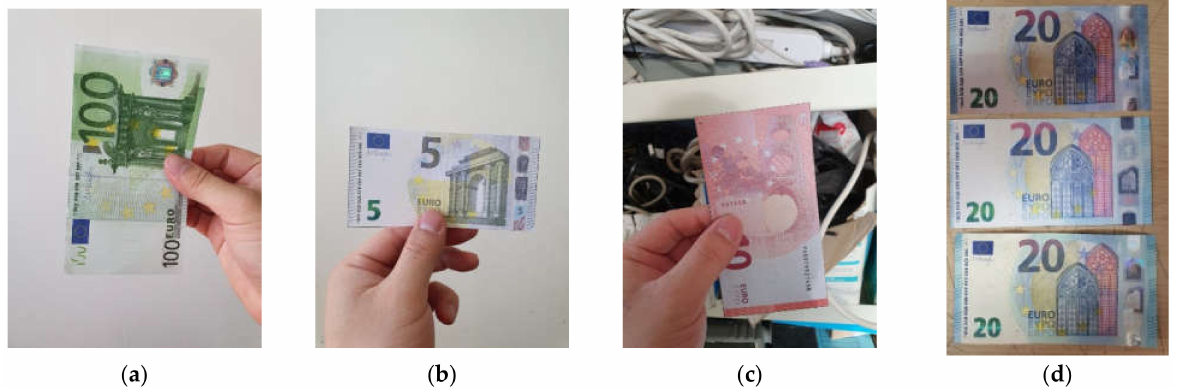
Figure 8. Examples of EUR banknote images in the dataset: ( a ) genuine, ( b ) scanner-reproduced, ( c ) smartphone-reproduced, and ( d ) a group photo of the three types, from upper to lower: smartphone-reproduced, scanner-reproduced, and genuine.